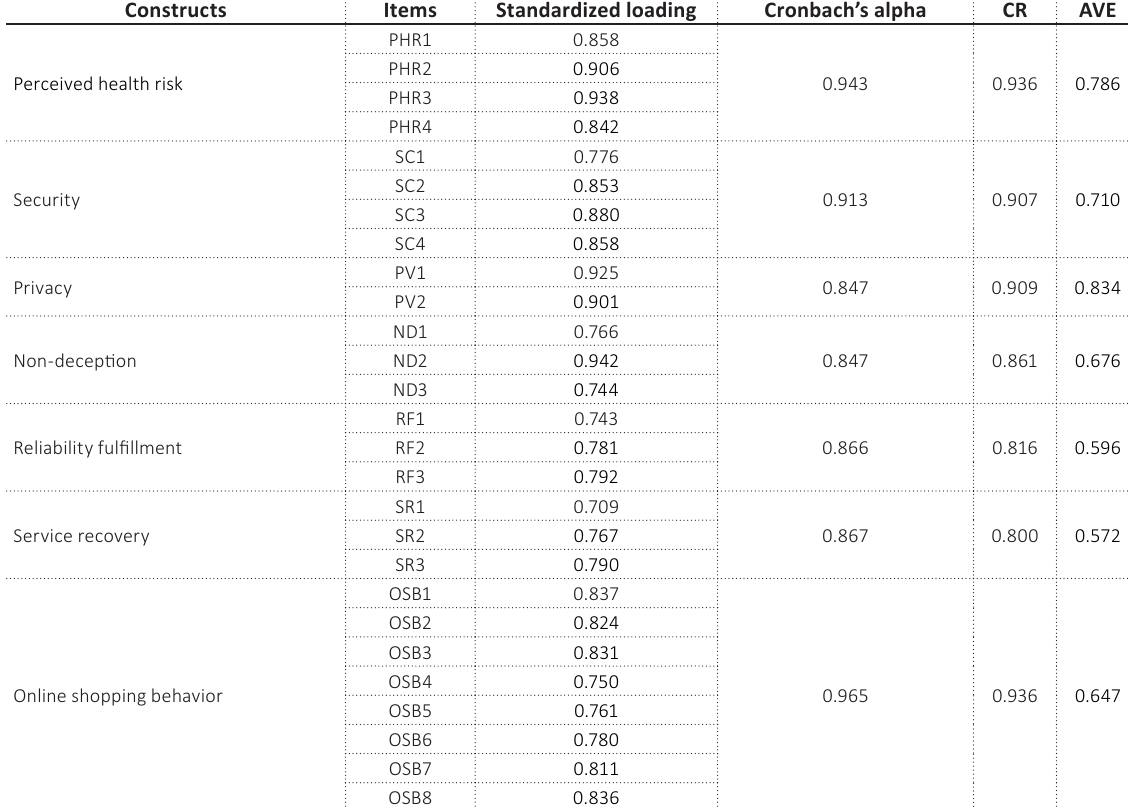
Table 2. Reliability and validity